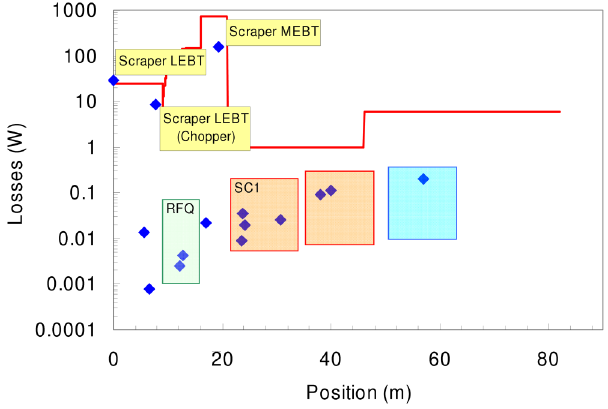
FIG. 6. (Color) Losses (W) along the structure, the loss limit requirements are the red line.